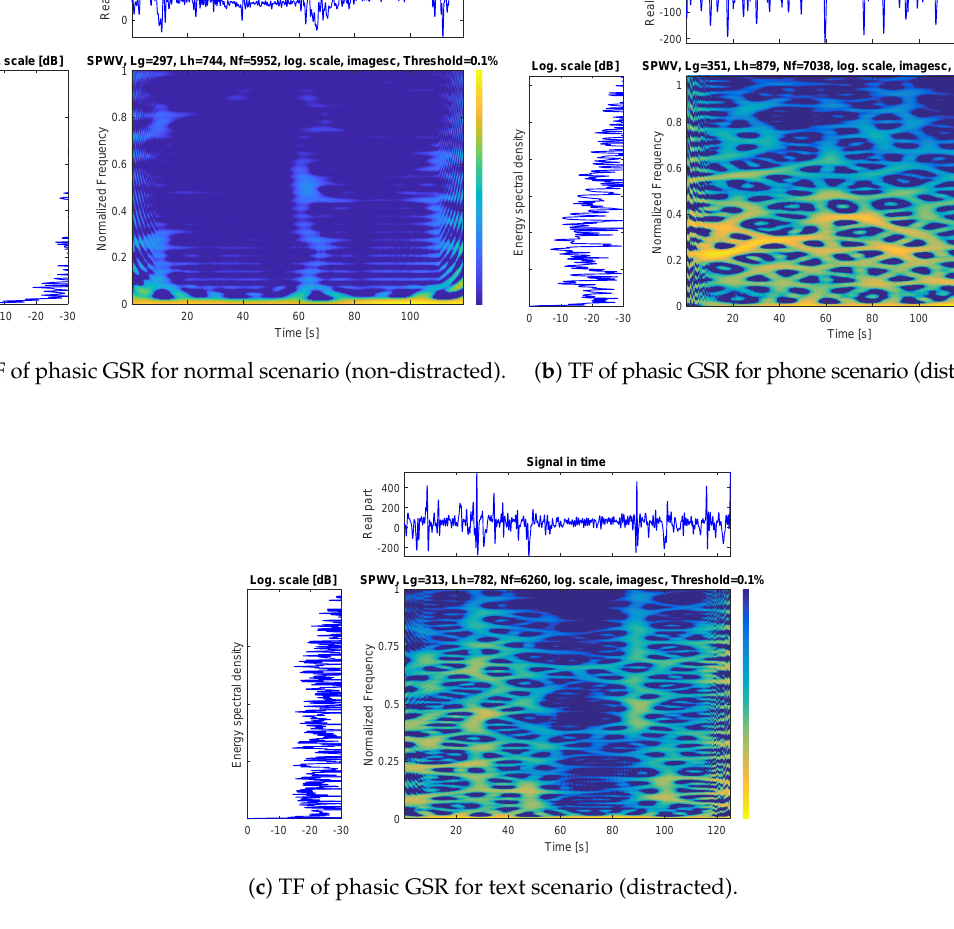
Figure 6. High-resolution time-frequency (TF) representation of the phasic component of GSR signal ( for each sub-plot ): ( top ): Phasic GSR Signal; ( left ): Energy Spectral Density and ( Spectrograph ): Time on the x -axis and frequency on the y -axis, and the color is used to indicate the power of the time-frequency